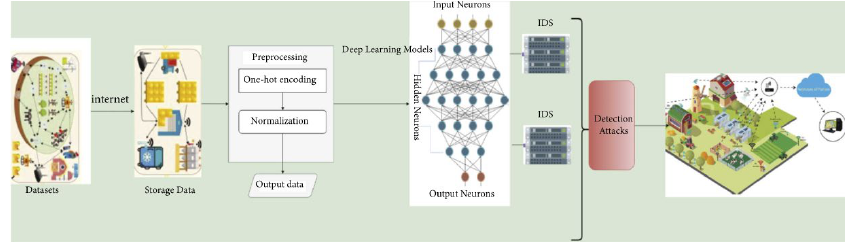
Figure 3. Framework of the proposed